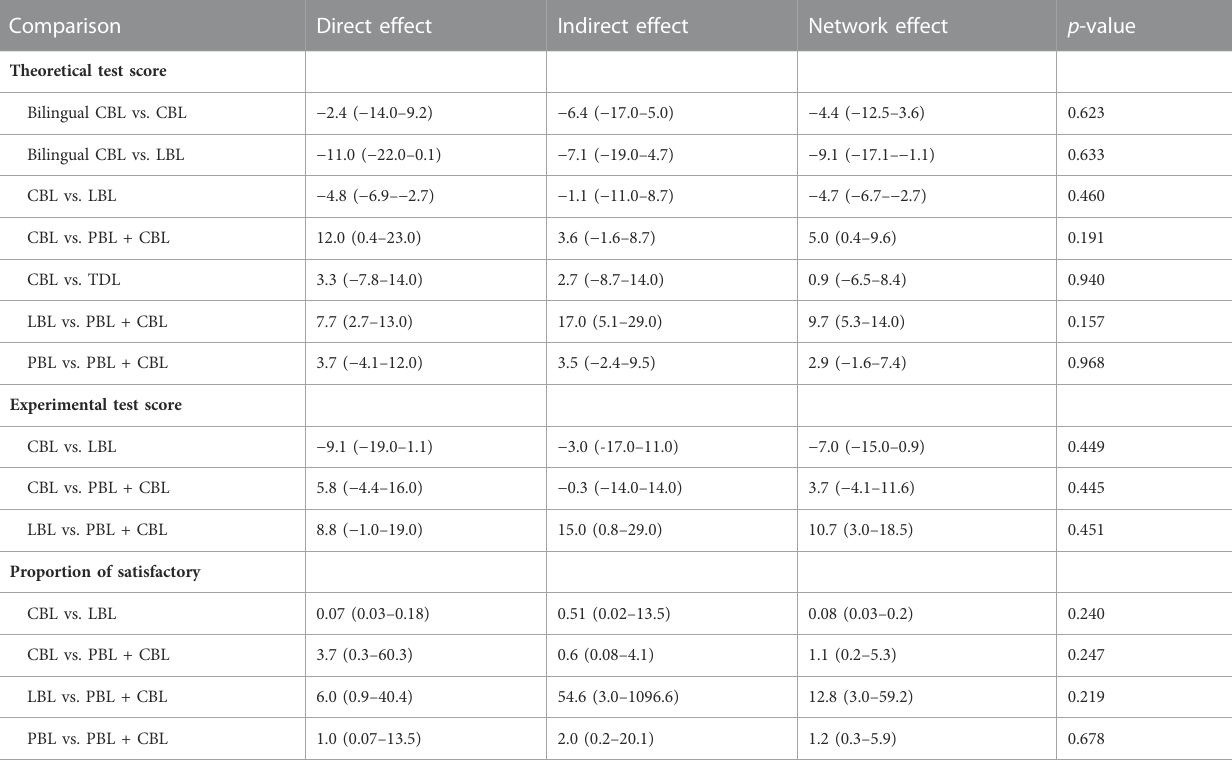
TABLE 2 Results of node-splitting